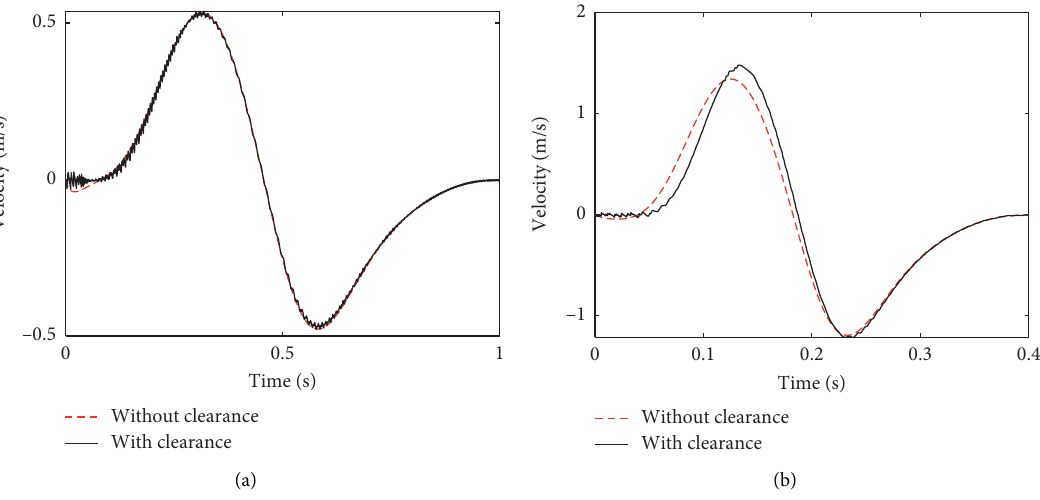
Figure 20: Velocity of the slider. (a) ω